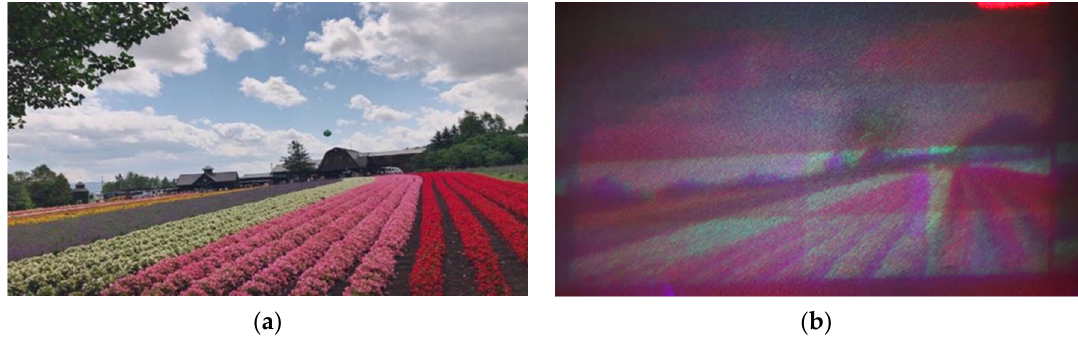
Figure 6. Color original image ( a ) and optically reconstructed image with color unevenness ( b ).